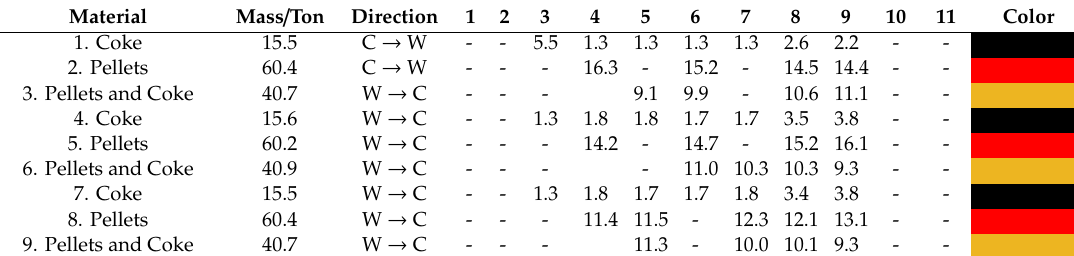
Figure 13. Simulated layer structure in the shaft of the reference BF operated under the charging program of Table 4. Table 4. Charging matrix of the validation case from an operating BF, with z = − 1.8 m as the charging